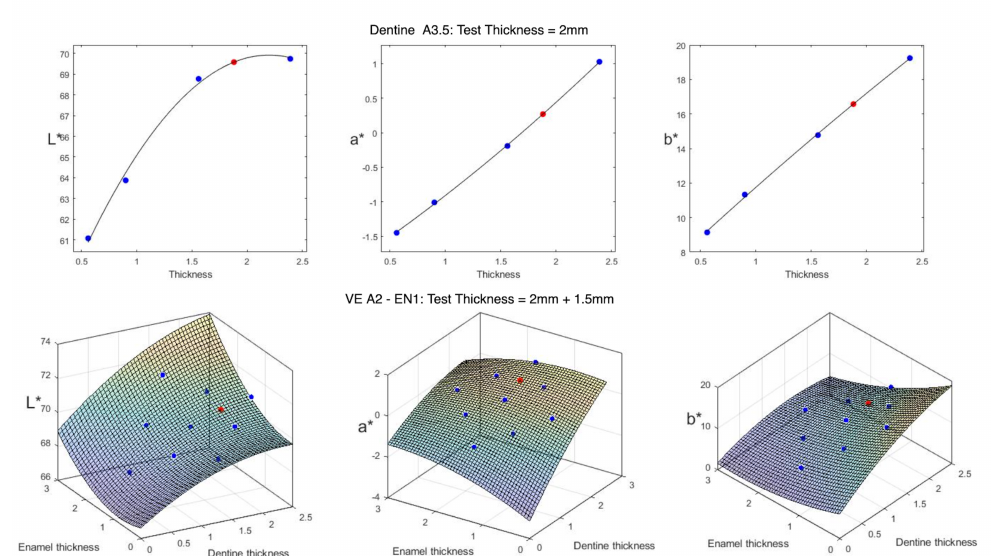
Figure 2. Examples of best-fit-curve ( top ) and best-fit-surface ( bottom ) for the CIE-L*, CIE-a* and CIE-b* color coordinates for monolithic and layered samples. Blue dots represent the values corresponding to the training set samples and red dots the values predicted by the model for a specific